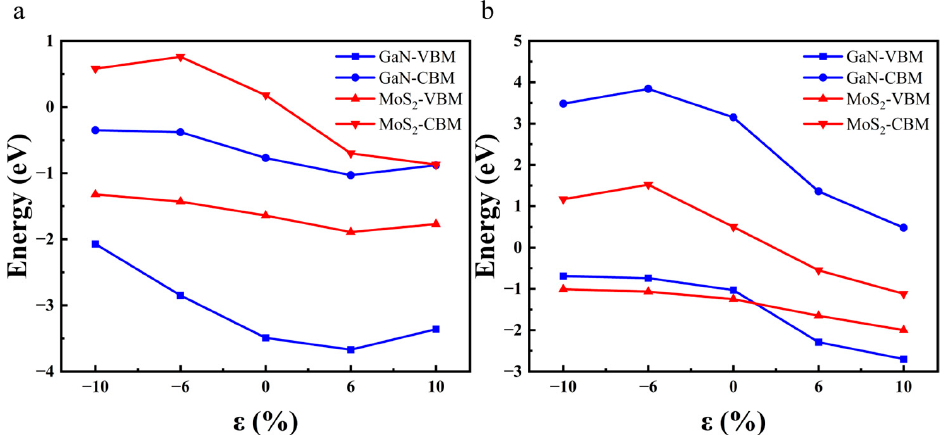
Figure 7. Band alignments of ( a ) GaN/MoS 2 (I) and ( b ) GaN/MoS 2 (II) heterostructures under biaxial strains of − 10%, − 6%, 0%, 6%, and 10%, respectively.